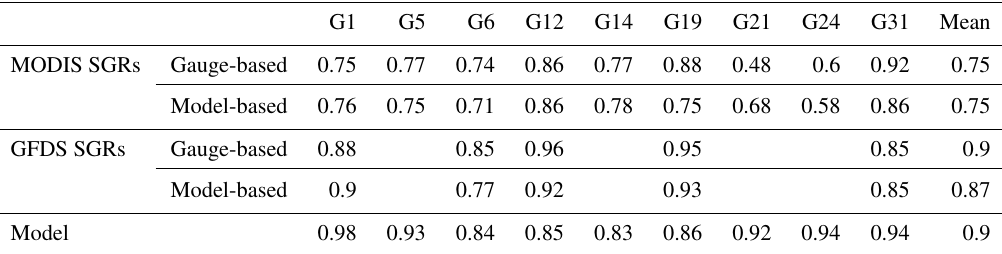
Table 3. Performance comparisons between gauge-based SGRs, model-based SGRs, and the W3 model (Pearson correlations between predicted and observed